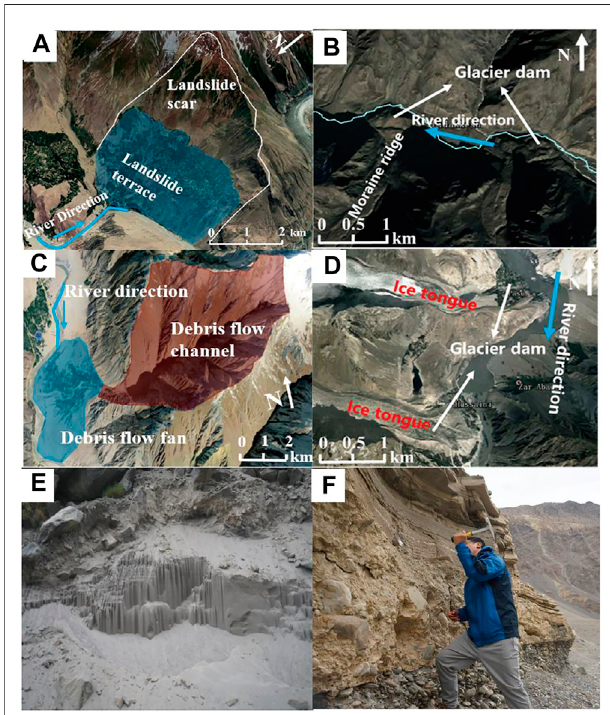
FIGURE 3 | Example of remote sensing interpretation of dams from high-resolution Google Earth images. (A) Landslide; (B) Glacier dam; (C) Debris fl ow; (D) Glacier dam; (E) Outburst fl ood sediment; (F) lacustrine sediments.